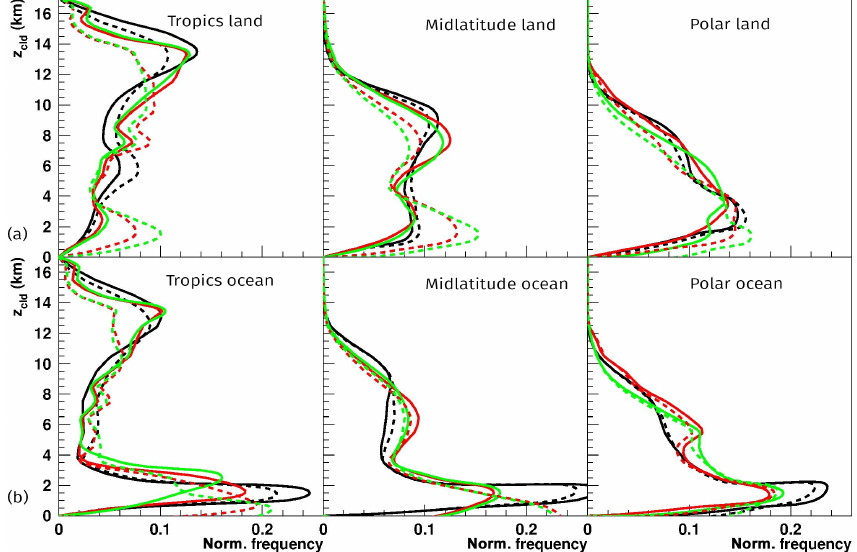
Figure 5. Normalized frequency distributions of z COD0 . 5 from CALIPSO (black) and of z cld from AIRS, using ancillary data from AIRS- NASA (red) and from ERA-Interim (green), separately over land (a) and over ocean (b) , in the tropics, midlatitudes and polar latitudes. For each data set, two distributions are compared: statistics of all detected clouds, except subvisible cirrus (dashed line), and only of single-layer clouds with a cloud coverage filling the AIRS golf ball (full